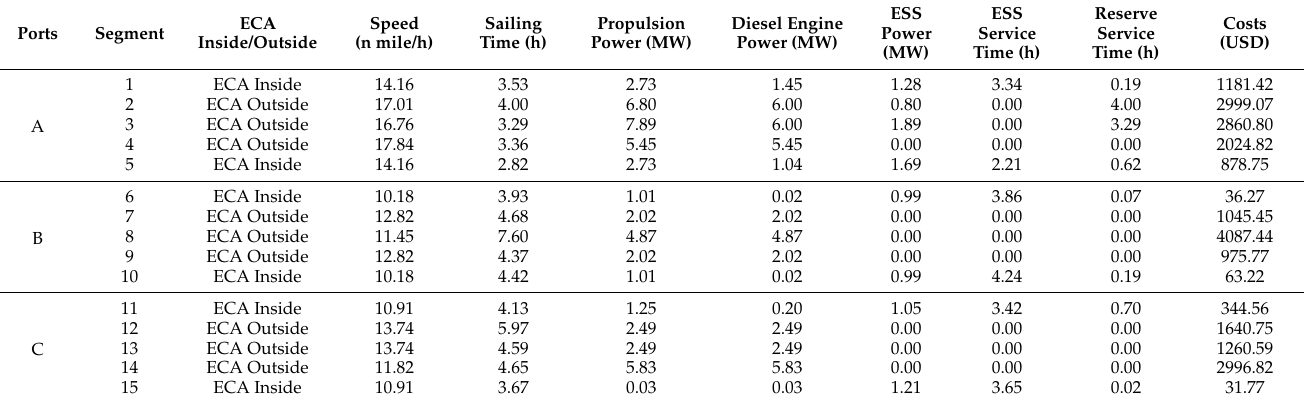
Table 9. The second stage energy management results under increased wind and wave influence.